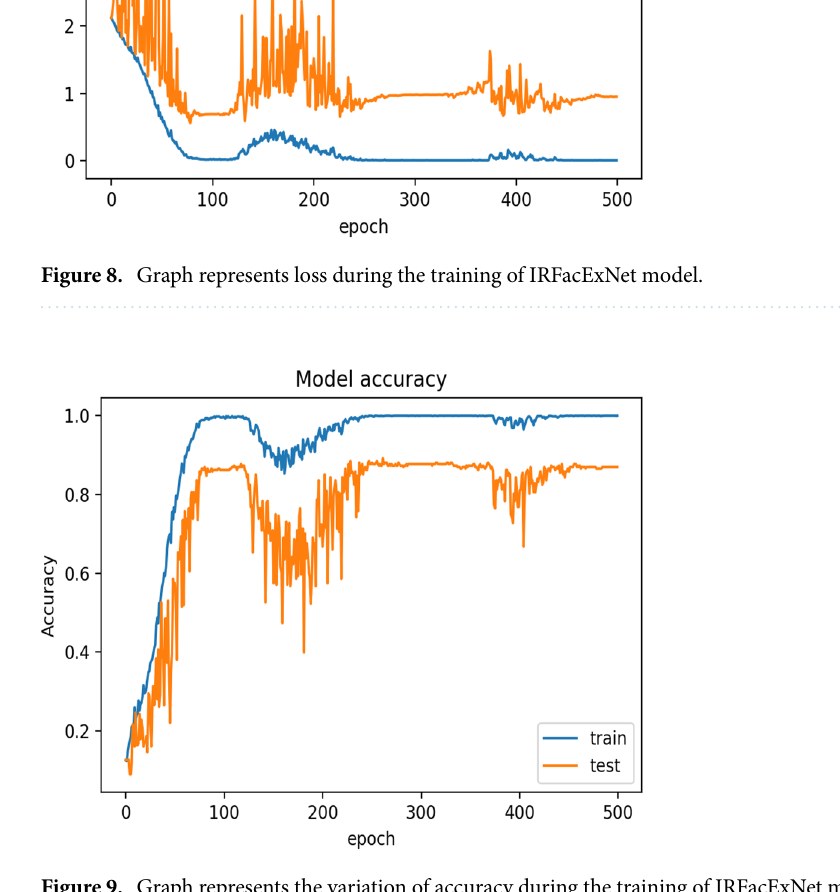
Figure 9. Graph represents the variation of accuracy during the training of IRFacExNet model.